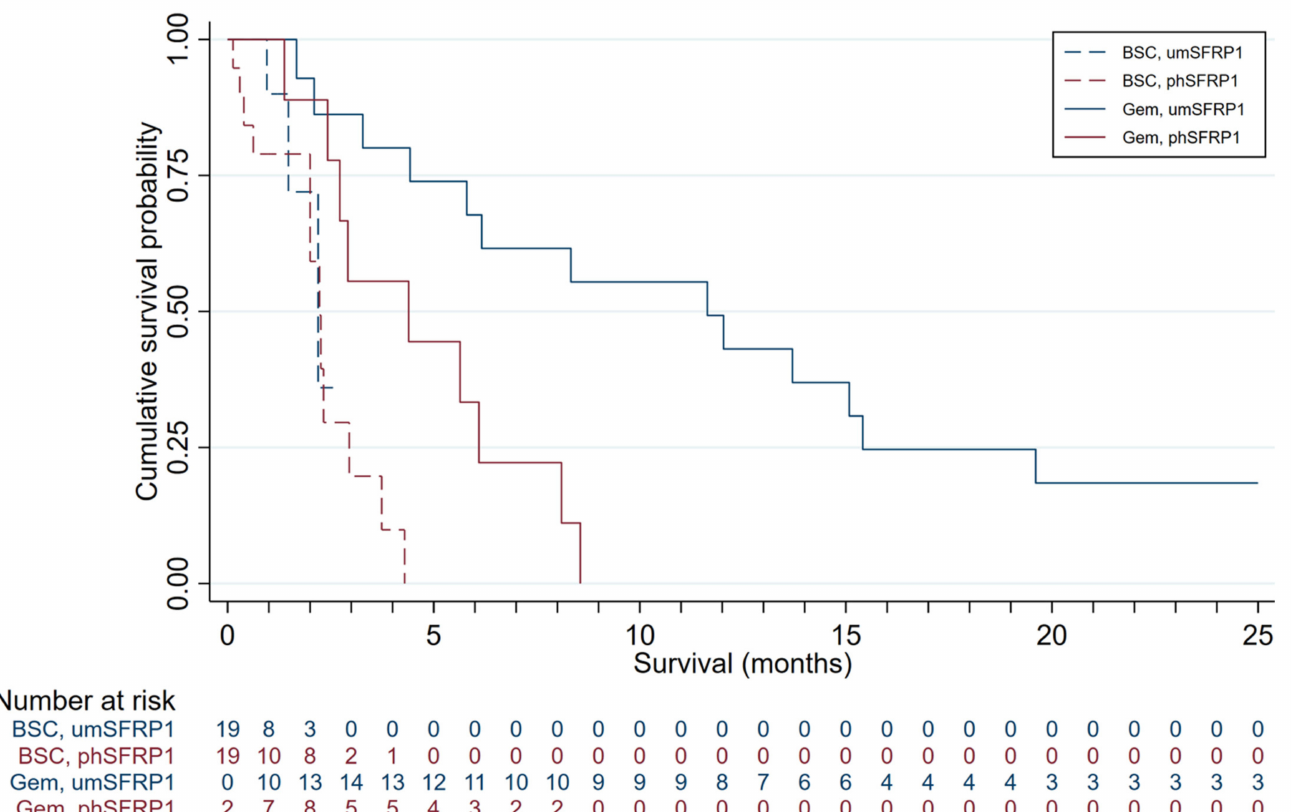
Figure 1. Kaplan–Meier survival distributions for patients included in the discovery cohort, grouped by SFRP1 promoter hypermethylation status and treatment. Gem-treated patients contribute survival time to the BSC group until the first day of first-line chemotherapy. Gem, patients treated with gemcitabine chemotherapy; BSC, patients receiving best supportive care; phSFRP1, patients with SFRP1 promoter hypermethylation; umSFRP1, patients without SFRP1 promoter hypermethylation. Risk table shows number of patients at risk in 1-month